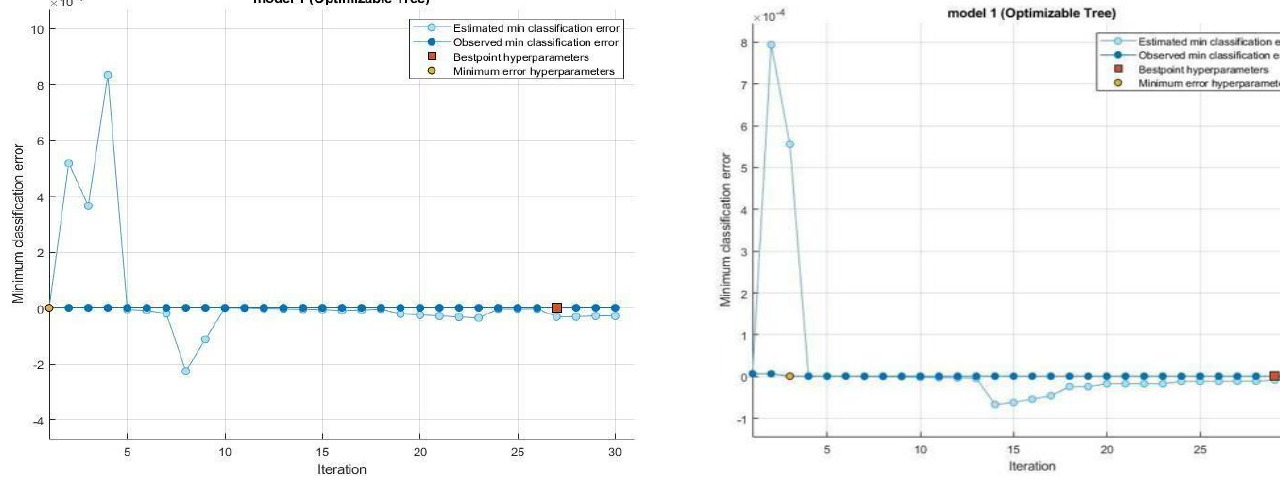
Fig. 9. ARP MitM minimum classification error of bayesian based optimized tree